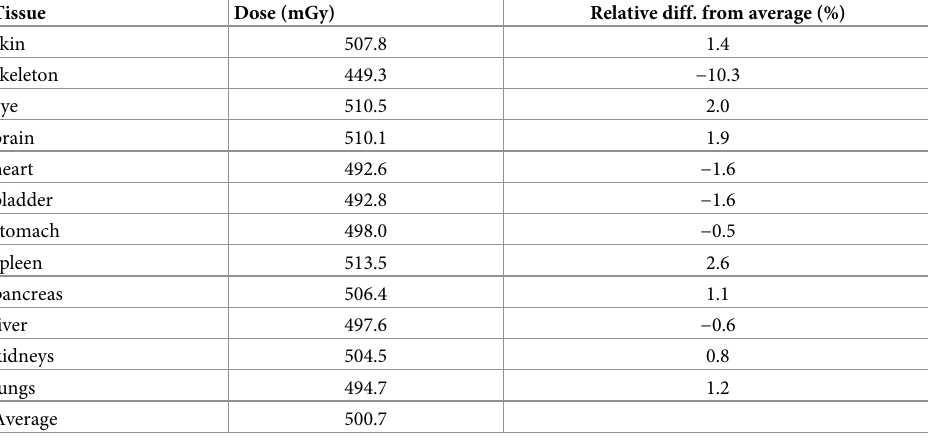
Table 4. Calculated Digimouse tissue and skeleton doses after pseudoisotropic (6 direction) irradiation with GCR simulator